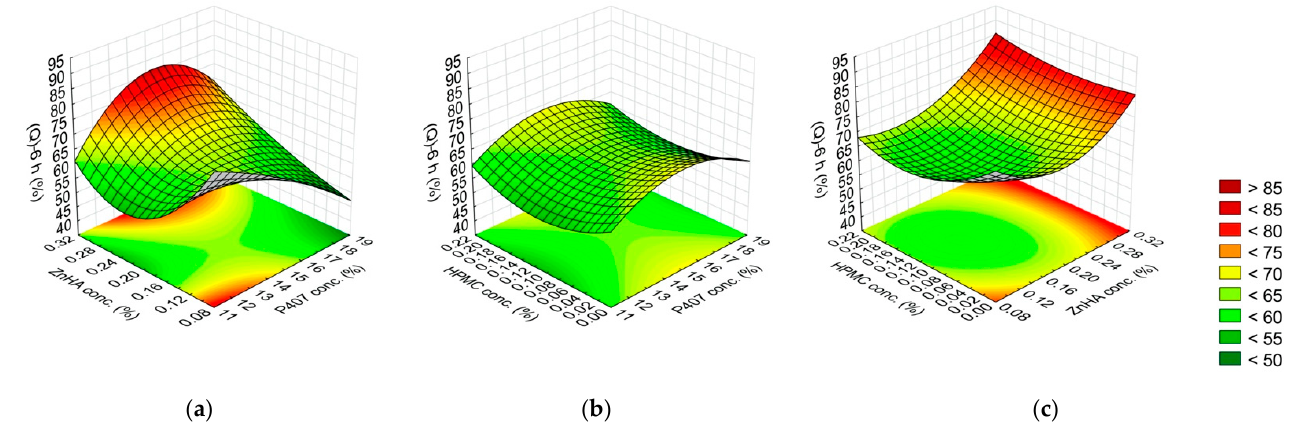
Figure 6. Effect of the composition on the released drug amount ((Q)-6 h): ( a ) P407 and ZnHA concentrations, ( b ) P407 and HPMC concentrations, ( c ) ZnHA and HPMC; (the 3rd factor is at 0 level in each case).